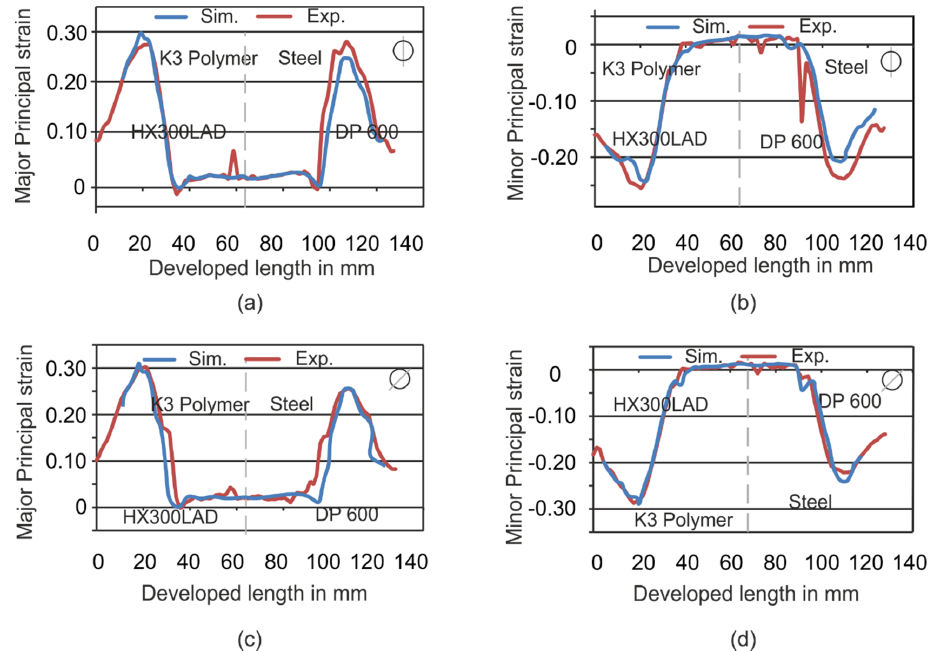
Figure 9. Comparison of major and minor strains of simulations and experiments for Setup 4. ( a ) Major strain for section in 90°, ( b ) minor strain for section in 90°, ( c ) major strain for section in 45° and ( d ) minor strain for section in 45°.